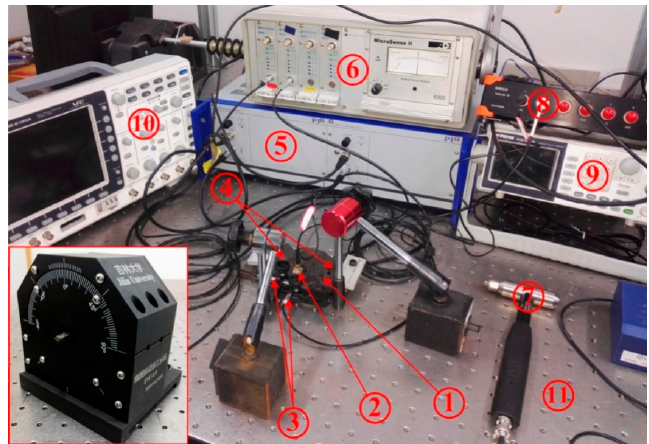
Figure 10. Photographic representation of the experimental setup for the 2-DOF PDCM system.